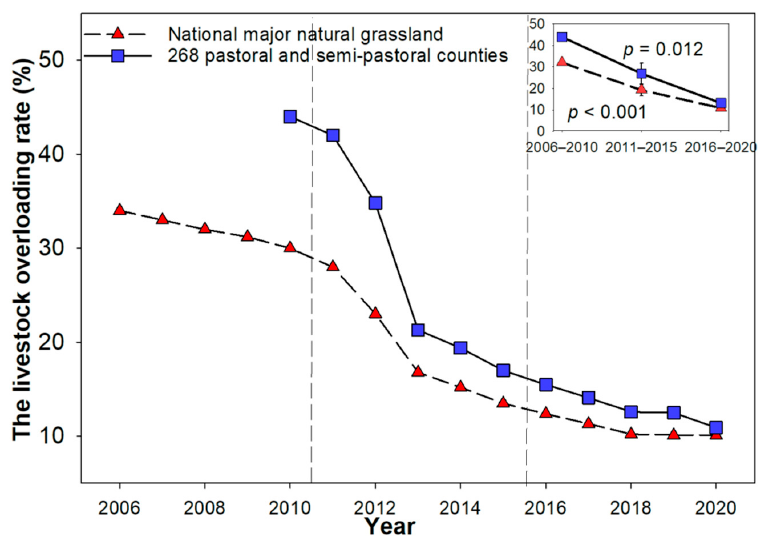
Figure 2. Average overloading rate of livestock in major natural grasslands and pastoral and semi- pastoral counties in China from 2006 to 2020.